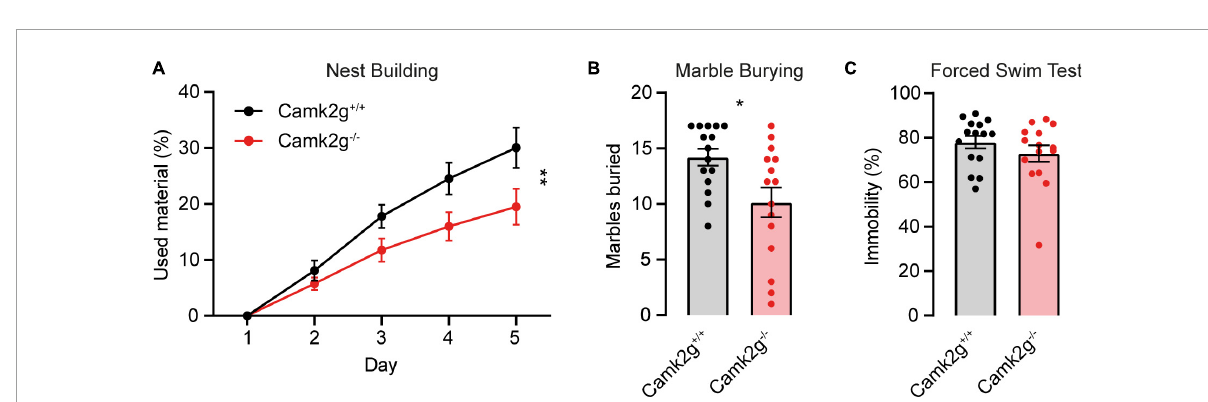
FIGURE5 CAMK2G in intrinsic behavior. (A) Camk2g − / − mice used less material to build nests than Camk2g + / + mice [two-way repeated measures ANOVA; interaction: F ( 4 , 112 ) = 4.55, p = 0.002]. (B) Camk2g − / − mice buried less marbles than Camk2g + / + mice [unpaired t -test, t ( 28 ) = 2.65, p = 0.013]. (C) No differences were found in the amount of time the mice spent immobile in the forced swim test (Mann–Whitney U test, U = 90.5, p = 0.372). Data represent mean ± SEM ( n = 15); * p < 0.05, ** p <